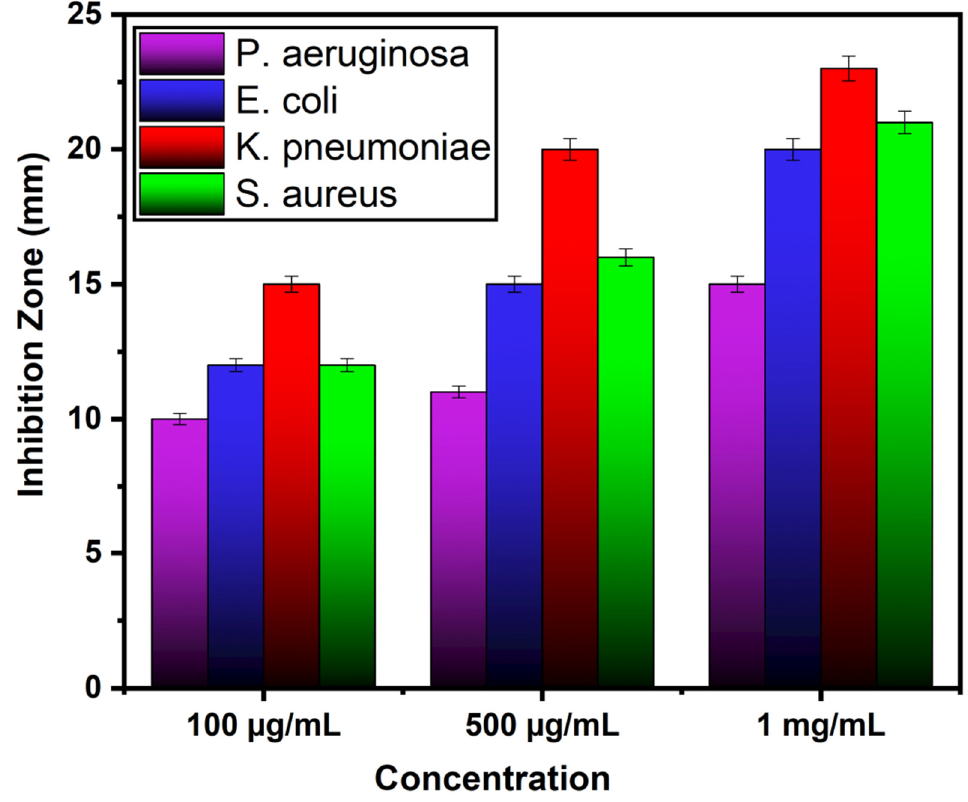
Figure 6. Bar graph showing the diameter of the zone of inhibition (in mm) produced by pure TiO 2 NPs. Table 1. The table summarizes the experimental parameters and detail of the bacteria.